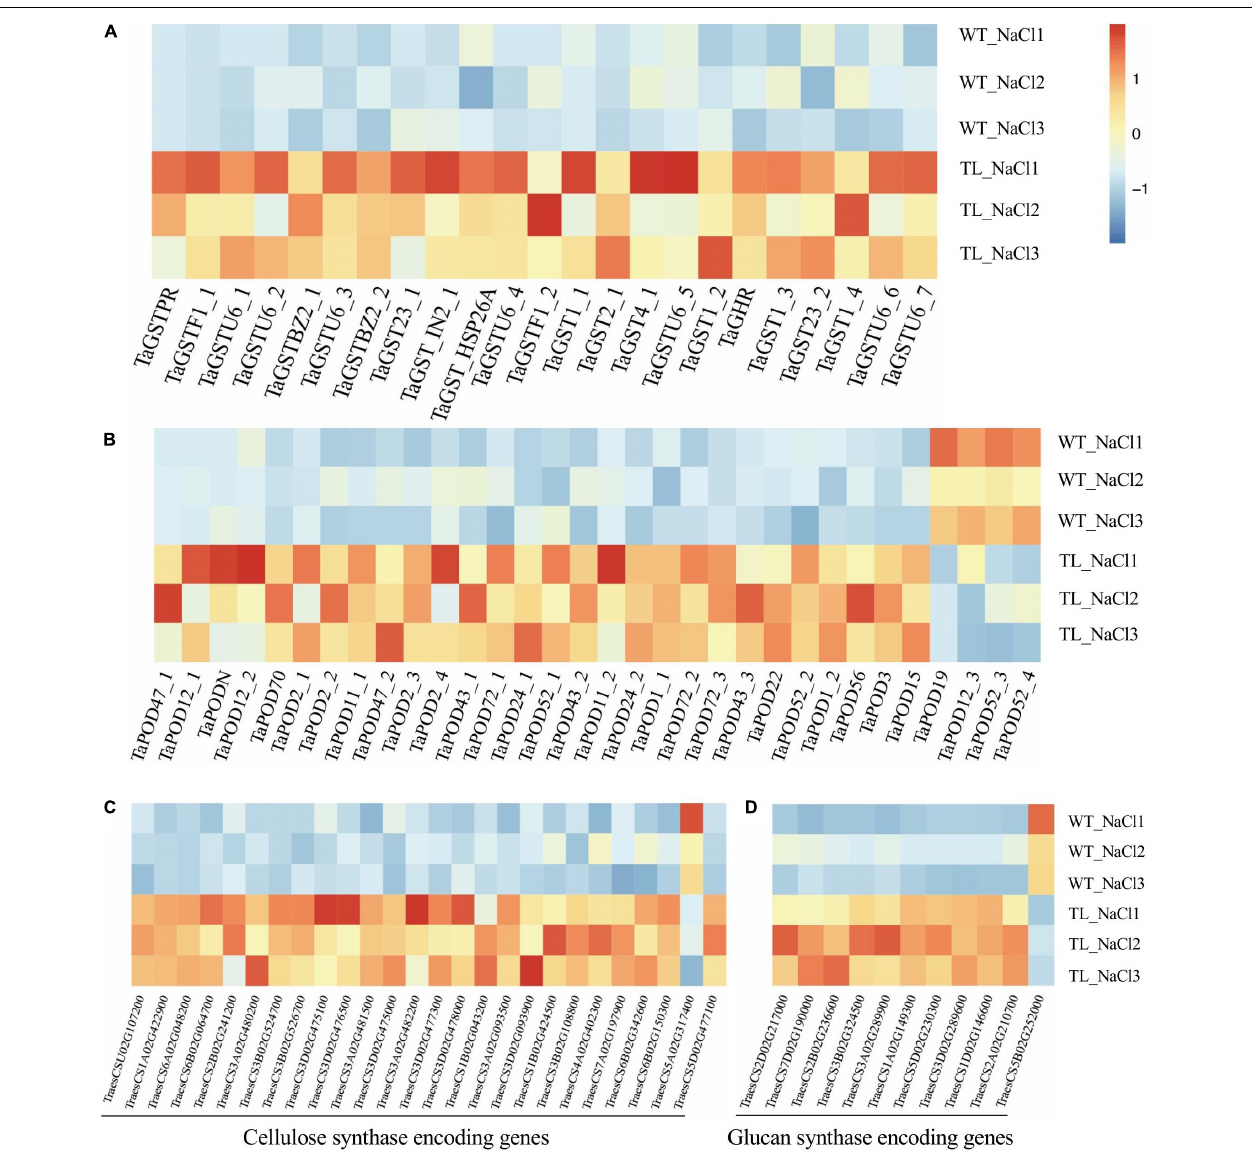
FIGURE 7 | Expression analysis of antioxidant enzyme encoding genes in the leaf sheath tissue of transgenic wheat upon salt stress in RNA-seq using a heat map. Expression analysis of glutathione transferase coding gene GST (A) , peroxidase (POD) coding gene POD (B) , cellulose synthase coding genes (C) , and glucan synthase coding genes (D) . The color legend indicates the expression level of DEGs (FPKM), where the redder the color represents the higher gene expression level, and the darker blue color represents the lower gene expression